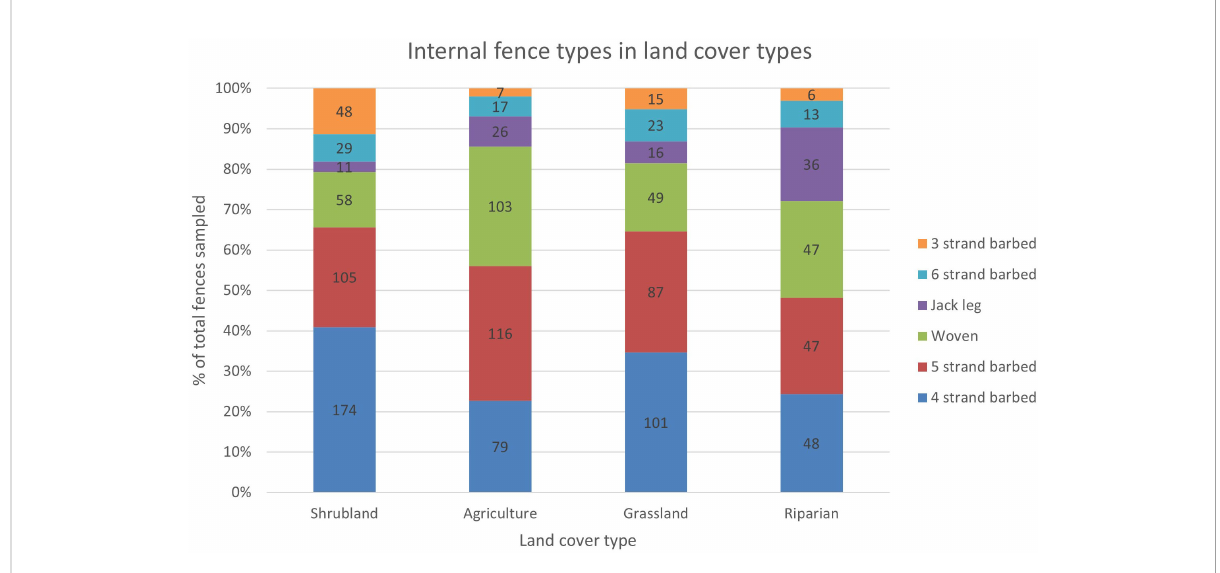
FIGURE 5 Proportions and counts of the six most common internal (i.e., pasture) fence types sampled in the four most common land cover types in Beaverhead and Madison Counties, MT (n = 1,372). Fence type and land cover type were correlated ( c 2 = 140.73, df = 15, p =